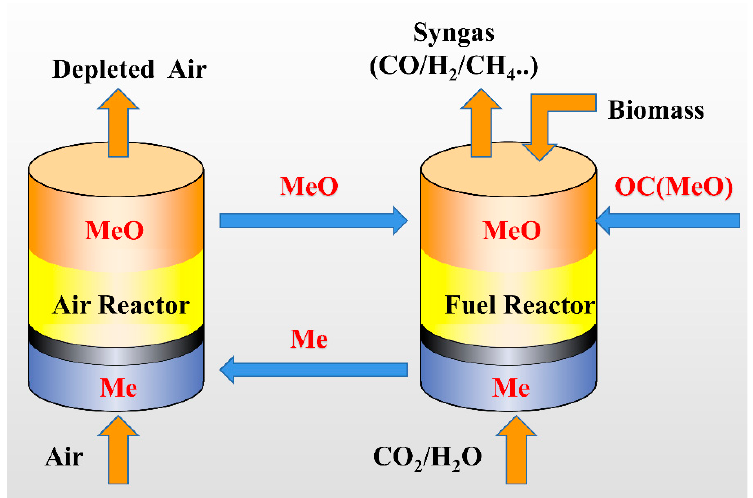
Figure 1. The schematic of biomass chemical looping gasification.